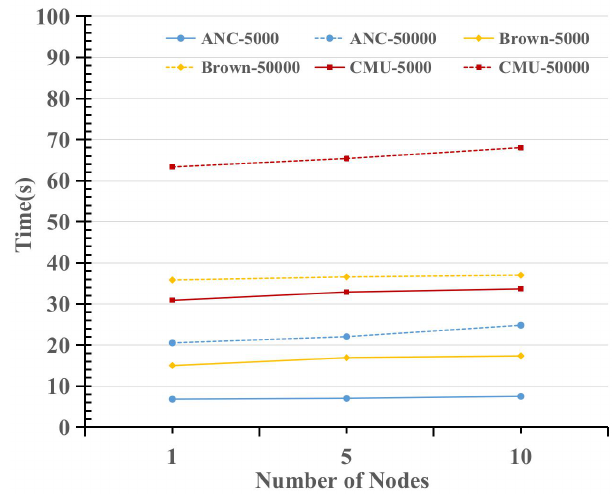
Figure 12. The time of remote update in HashMap (256 kB).